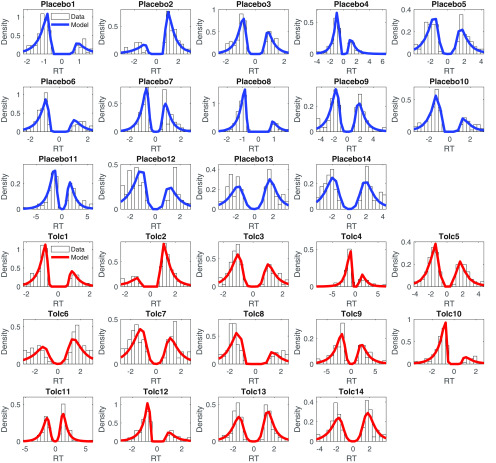
Posterior predictive plots of the drift diffusion temporal discounting model with nonlinear value scaling of the drift rate (DDMS) for all 14 participants (blue: placebo, red: tolcapone). Histograms depict the observed RT distributions for each participant. The solid lines are smoothed histograms of the model predicted RT distributions from 1000 individual subject datasets simulated from the posterior of the best fitting hierarchical model. RTs for smaller-sooner choices are plotted as negative, whereas RTs for larger-later choices are plotted as positive. The x-axes are adjusted to cover the range of observed RTs for each participant.